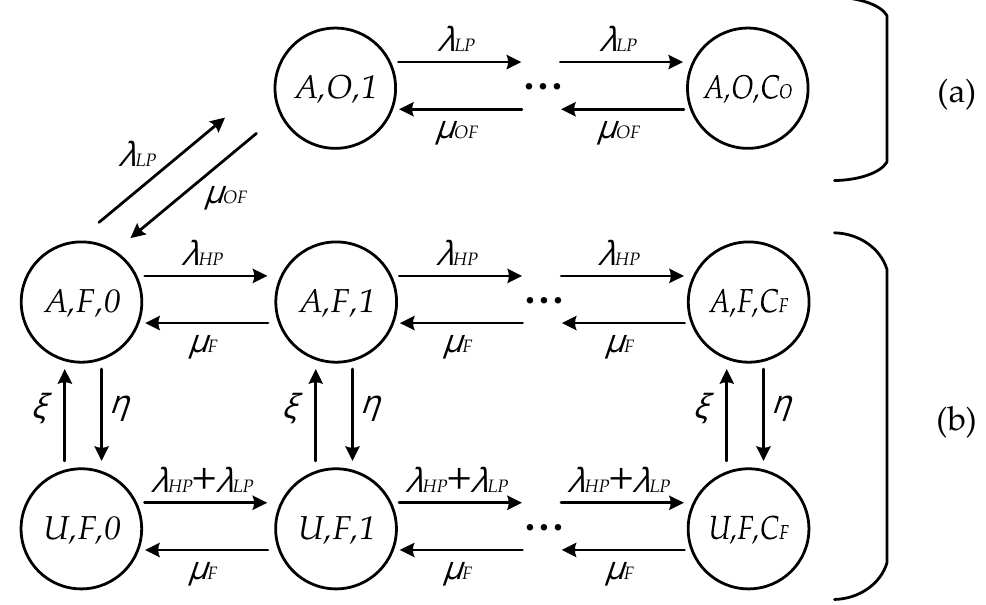
Figure 2. Markov chain model of the proposed scheme: ( a ) OFN; ( b ) FN. The transition rates of FN in Figure 2 can be obtained as follows.